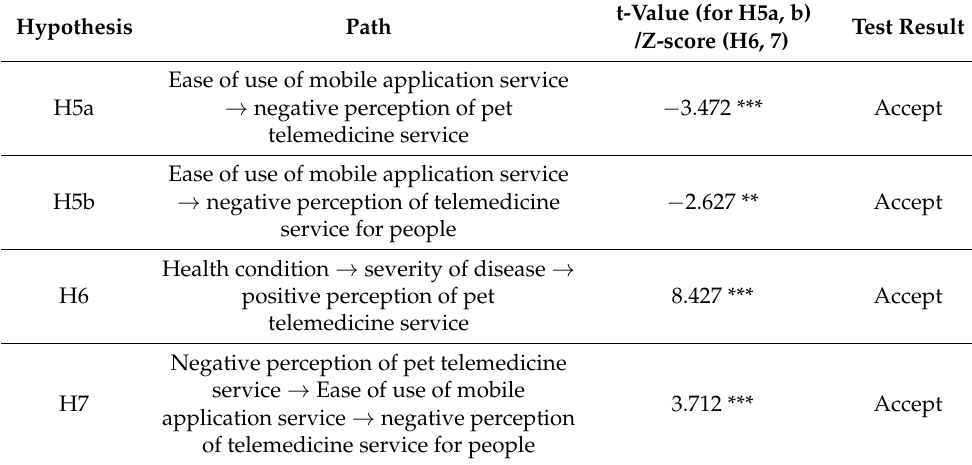
Table 8. Result of moderation